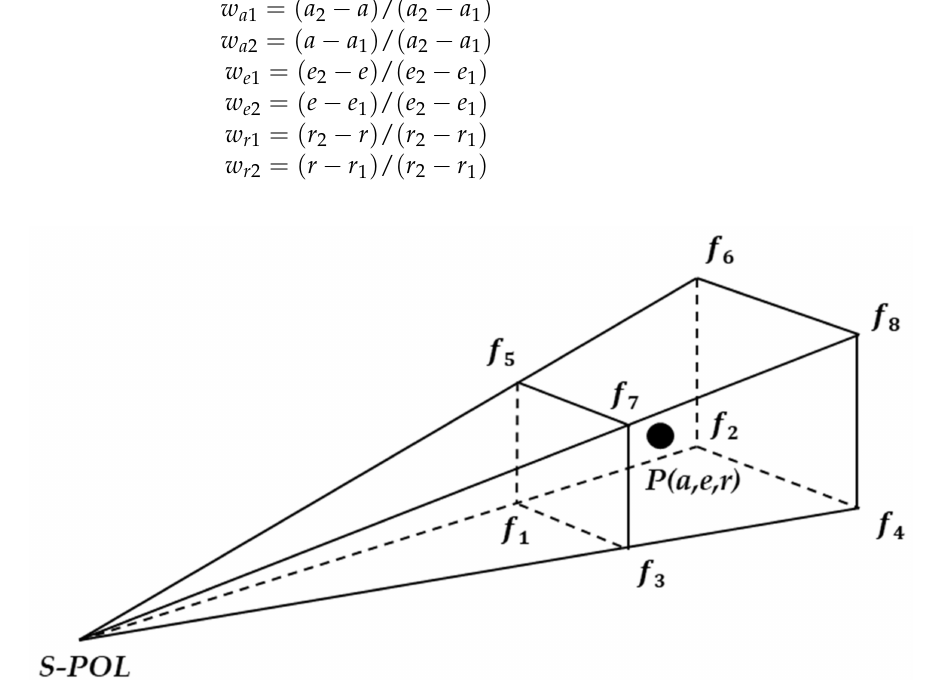
Figure 3. Eight-gate interpolation diagram, where P is the X-PAR observation gate, ( a , e , r ) is the S-POL radar coordinate of P , and f 1 – f 8 are the eight gates adjacent to P in S-POL